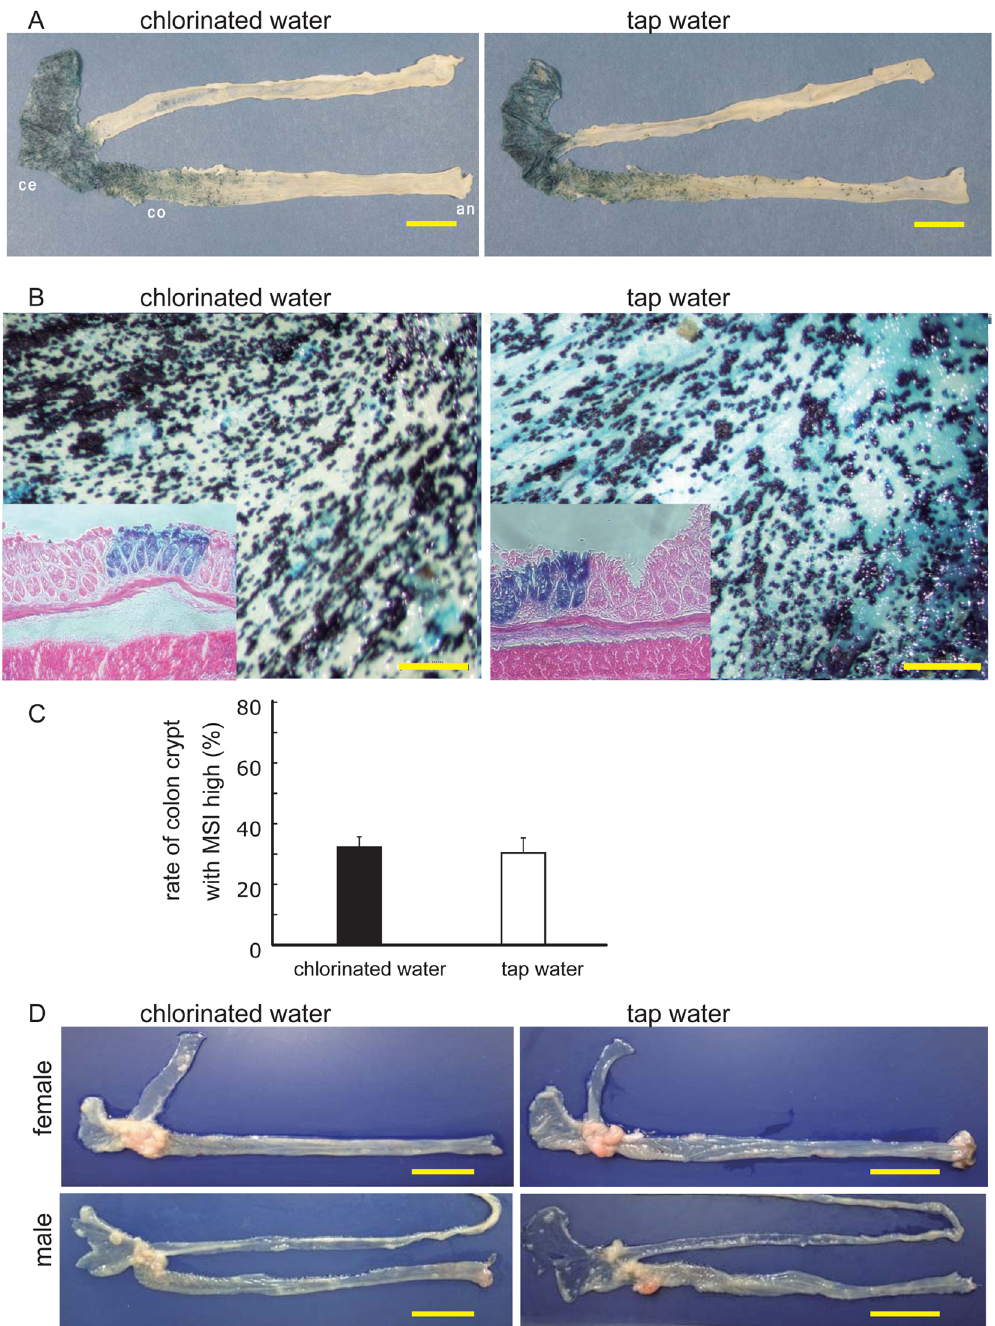
Fig 4. Cre activation in CDX2P9 . 5-G19Cre;R26R mice. A, X-gal activity in cecal crypt in a 20-week-old CDX2P9 . 5-G19Cre;R26R mouse. ce, cecum; co, colon; an, anus. Bar, 10 mm. B, Stereomicrograph (45×) of the cecal epithelium (small box) with X-gal and eosin staining of a 20-week-old CDX2P9 . 5-G19Cre;R26R mouse. Bar, 1 mm. C, Quantitative analysis of X-gal staining in 20-week-old CDX2P9 . 5-G19Cre;R26R mice. Cells were counted in six fields; data represent mean ± SD. D, Dissected ileum and colorectal tract of CDX2P9 . 5-G22 Cre;Apc flox/flox mice with cecum-proximal tumors. Left, tissue sample from a 15-week-old mouse treated with chlorinated water (10.0 mg/mL). Right, tissue sample from a 15-week-old mouse treated with tap water (0.7 mg/mL). Bar, 10 mm.